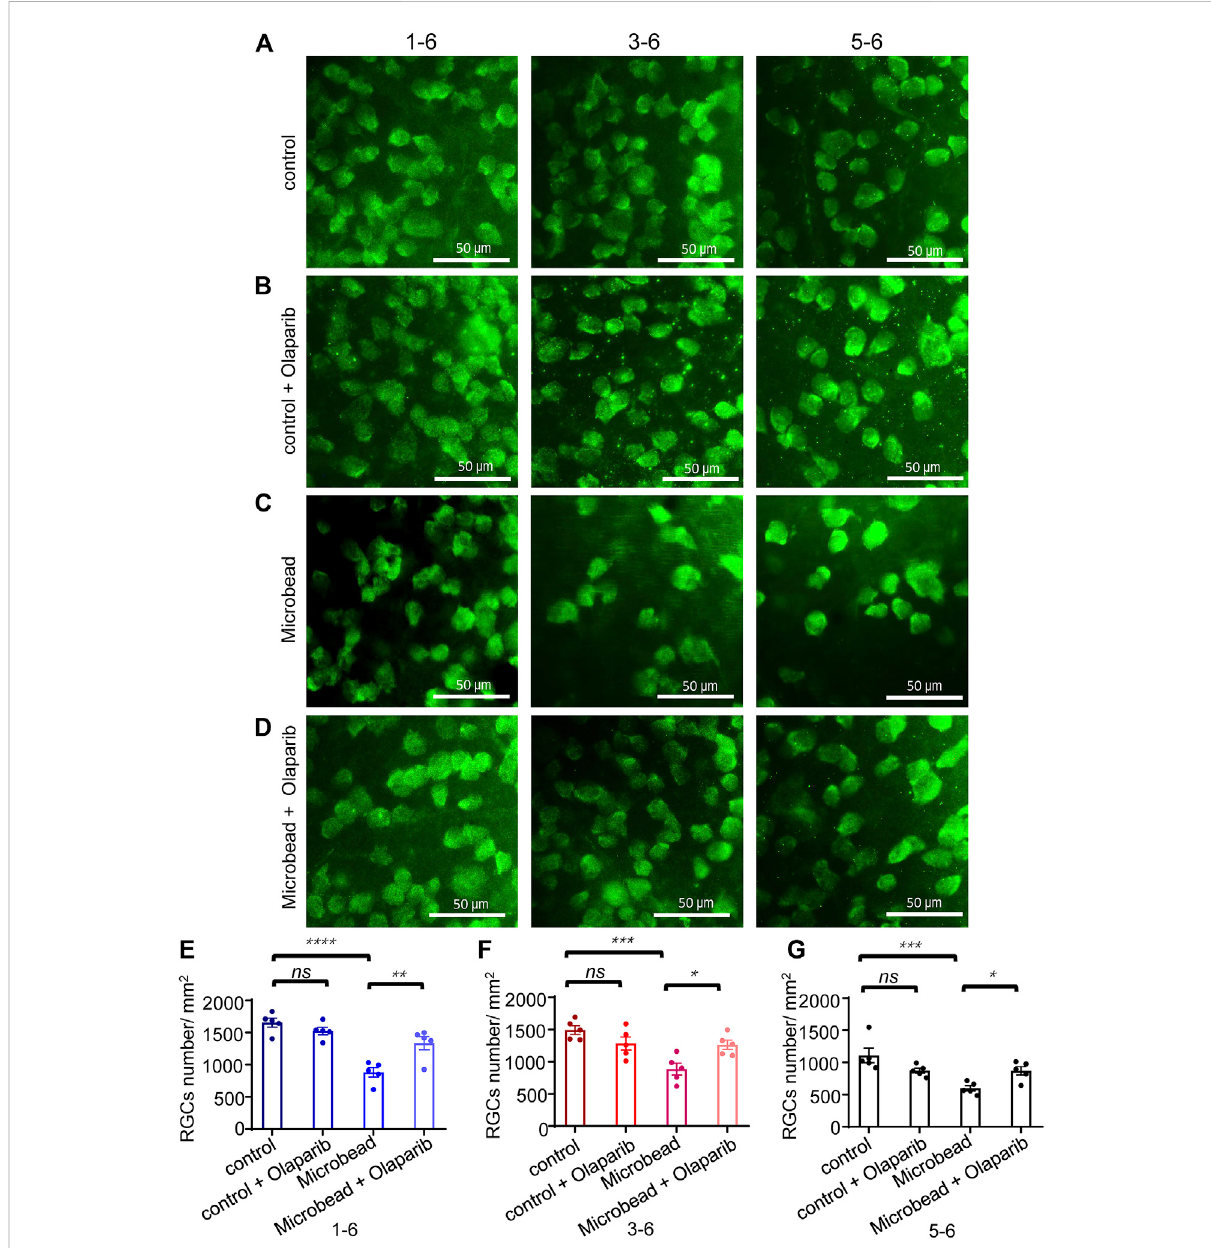
FIGURE 4 Olapariballeviateschronicocularhypertension-inducedRGCloss. (A – D) Immuno fl uorescencestainingwithRBPMSofwhole-mountretinasof thecontrol group, control + olaparibgroup, microbead group, andmicrobead+ olaparibgroup, respectively. (E – G) The bar chart shows thedensity ofsurviving RGCsfromthefourgroups.The p -valuesweredeterminedusingone-way ANOVAwithTukey ’